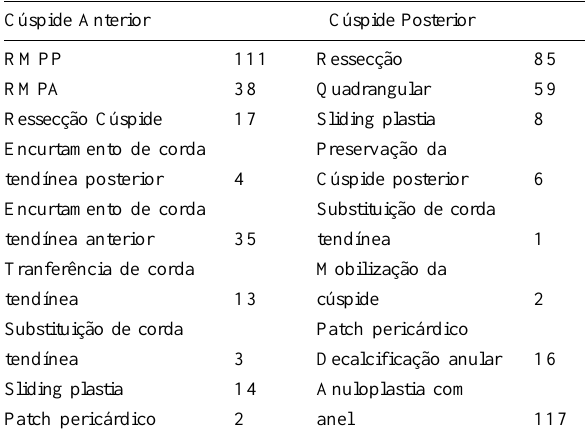
Fig. 3 - Técnica cirúrgica de reposicionamento do músculo papilar. O ponto em U é suturado no segmento fibroso da cabeça anterior e atado na cabeça